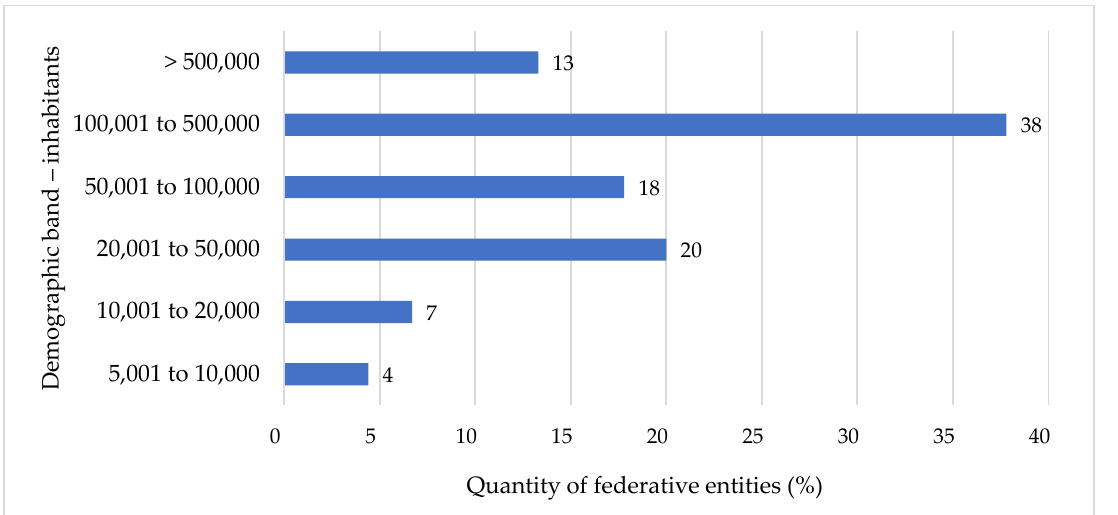
Figure 3. Demographic bands from the federative entities that have WSP in the preparation process